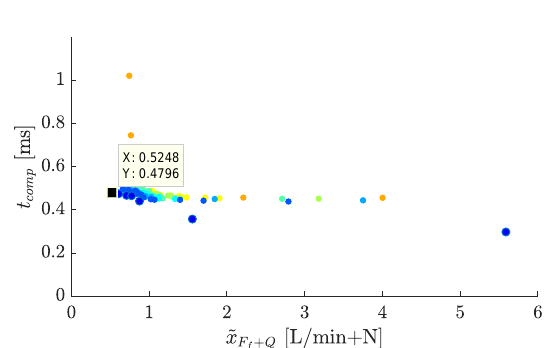
Figure 13: Pareto front of showing the surrogate accu- racy vs the time required to call the surro- gate